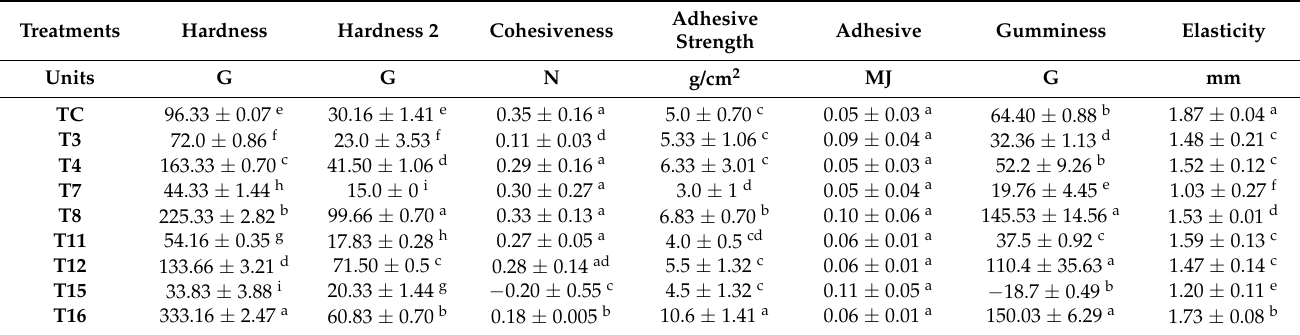
Figure 2. Proposal for forming covalent bonds between the molecules of the hydrocolloids extracted from the waste matter of Opuntia pads that form a gel. ( A ) Molecular gelation proposal for agar-agar and Opuntia mucilage. ( B ) Molecular gelation proposal for agar-agar and Opuntia pectin. Table 1. Texture profile analysis (TPA) and mechanical performance of obtained